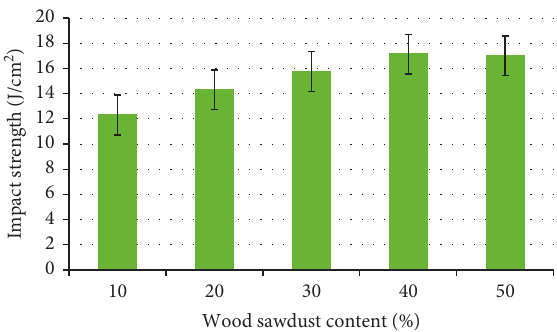
Figure 5: Effect of sawdust content on impact strength.